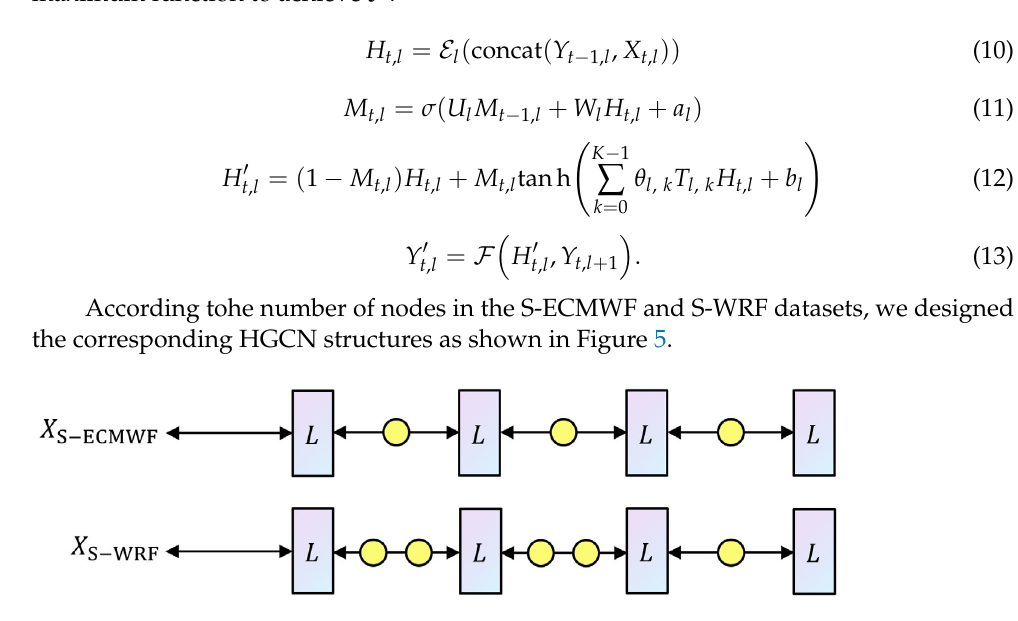
Figure 5. Hierarchical graph convolutional networks adapted to S-ECMWF or S-WRF datasets, where boxes represent one layer, circles represent graph data pooling and de-pooling operations .